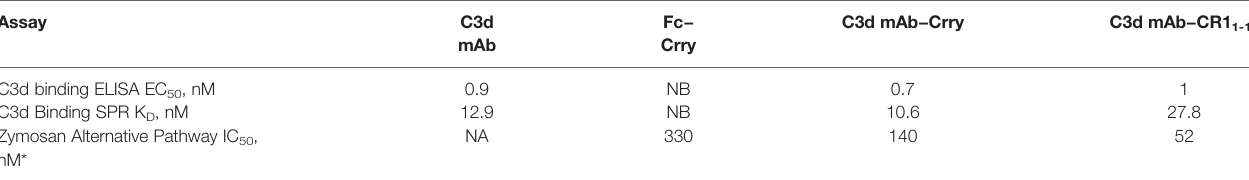
TABLE 2 | Binding af fi nity to C3d and functional activity of C3d mAb, Fc-Crry, C3d mAb – Crry and C3d mAb – CR1 1-10 . Assay